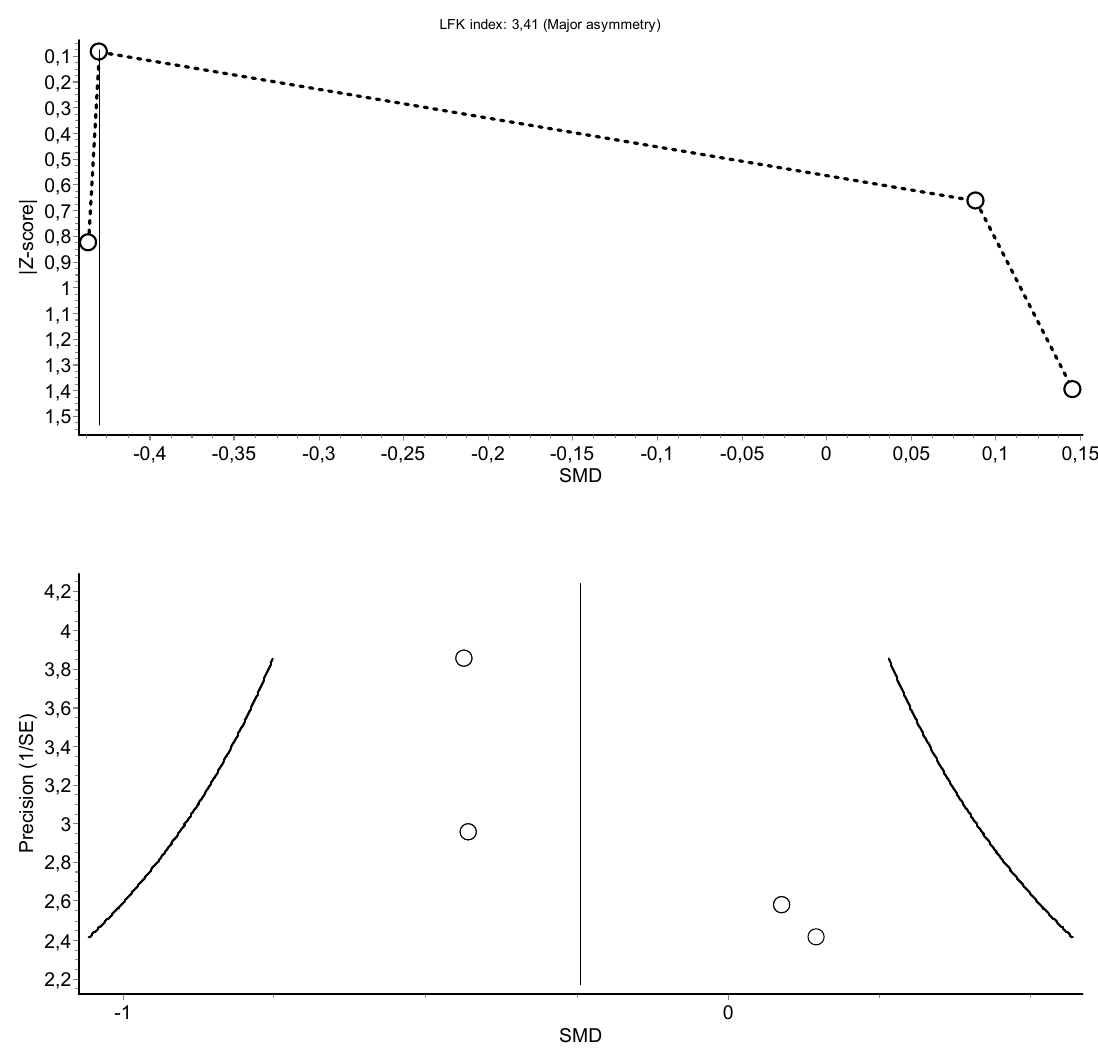
Figure A8. Synthesis forest plot of body fat variable. Negative favor HIIT intervention. The forest plot summarizes the results of included studies (standardized mean differences [SMDs] and weight). The small boxes with the squares represent the point estimate of the effect size and sample size. The lines on either side of the box represent a 95% confidence interval (CI).